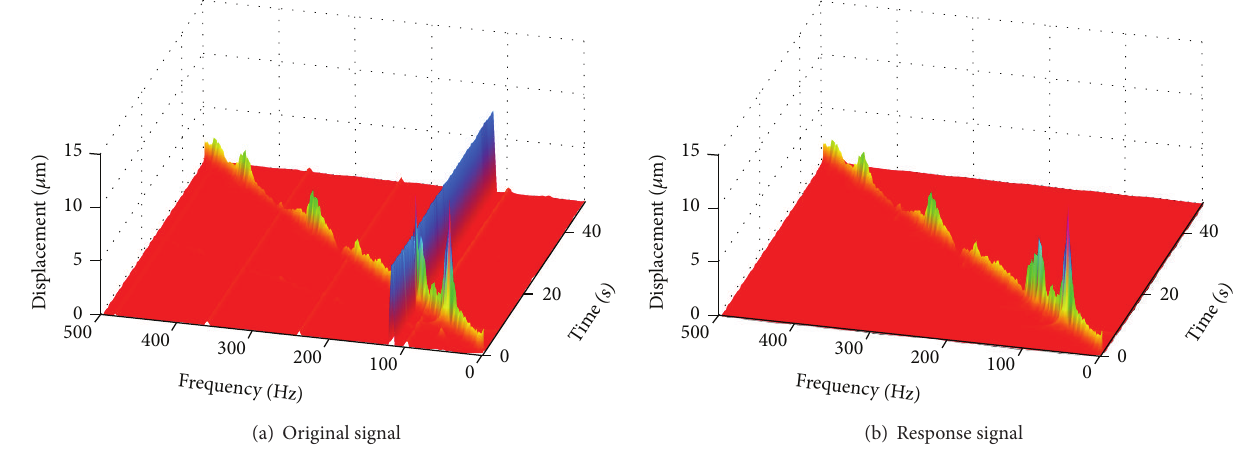
Figure 11: The comparison before and after the error separation processing.